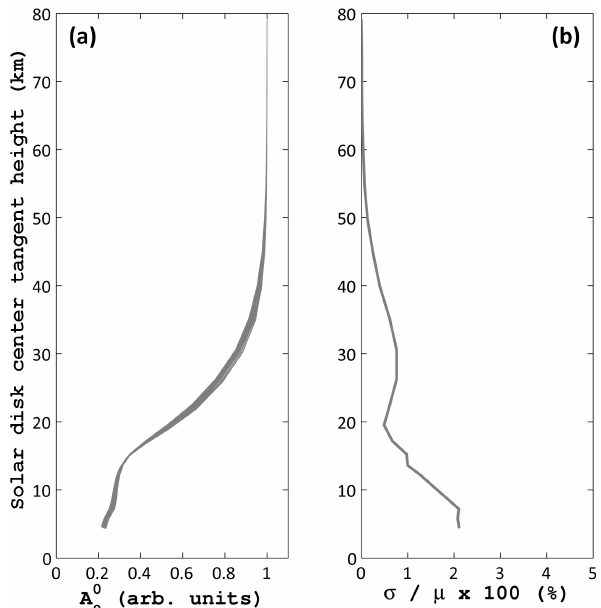
Fig. 7. Left panel shows the moment amplitude of the first Zernike polynomial computed for every simulated solar disk image and ev- ery profile of the CIRA-86 climatology. At the beginning of the oc- cultation, the weakness of the refraction makes the Zernike moment insensitive to the particular pressure of the upper atmospheric lay- ers. At lower altitudes, the moment starts taking different values for different pressure profiles. This is emphasized in the second panel where the standard deviation of the moment amplitude is compared to the mean